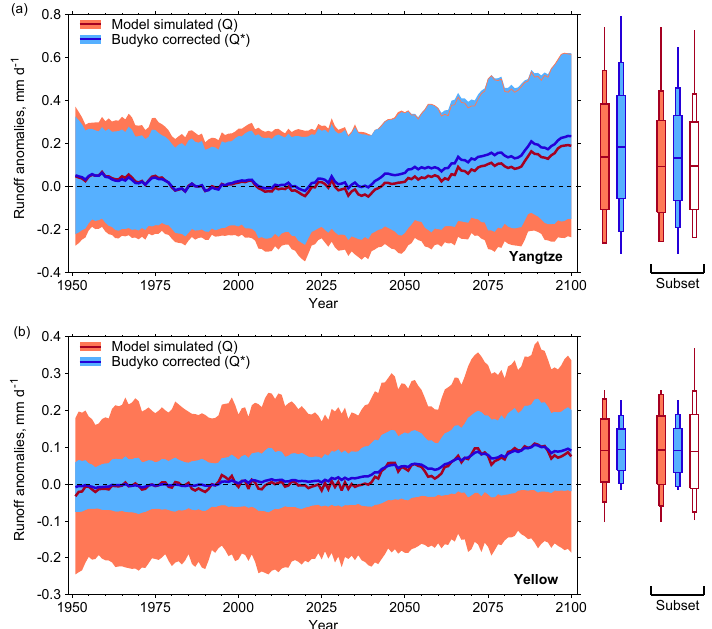
Figure 11. CMIP5 model-simulated ( Q ; orange) and CMIP5 Budyko-corrected ( Q ∗ ; blue) runoff anomalies for 1951–2100, relative to 1980– 1999, for the Yangtze (a) and Yellow (b) River catchments in the historical and RCP8.5 experiments. Shown are the 5-year running multi- model mean (thick line) and 5%–95 % ranges (shading) across the CMIP5 ensemble. The box plots (mean, ± 1SD ranges, 5%–95% ranges, and minimum to maximum ranges) are given for 2080–2099 (Table 1). Also shown, for comparison, are box plots for a subset of 28 (from 34) CMIP5 models for which Q is directly simulated (not limited to being calculated as P − E ). The unfilled box plot shows CMIP5 model directly simulated runoff for